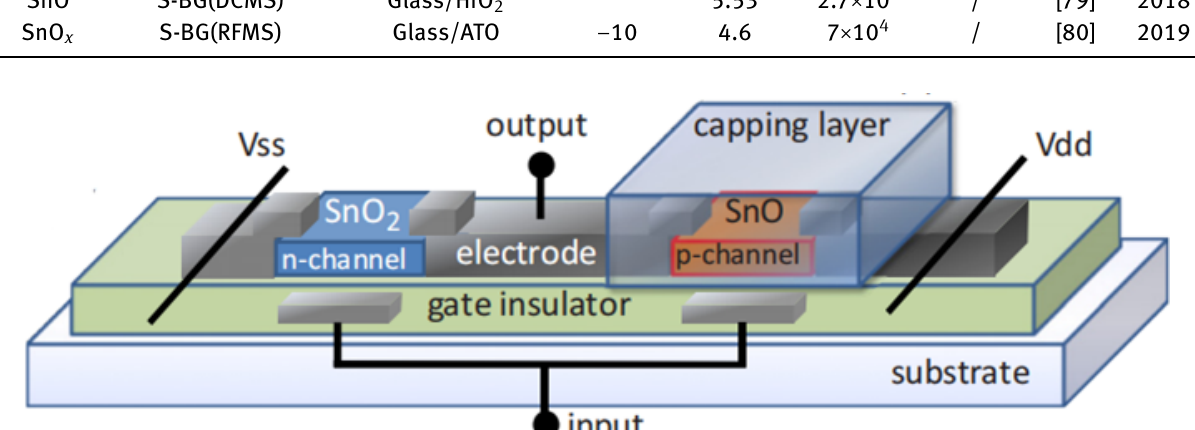
Figure 15: A conceptual design of a SnO-based CMOS inverter [63]